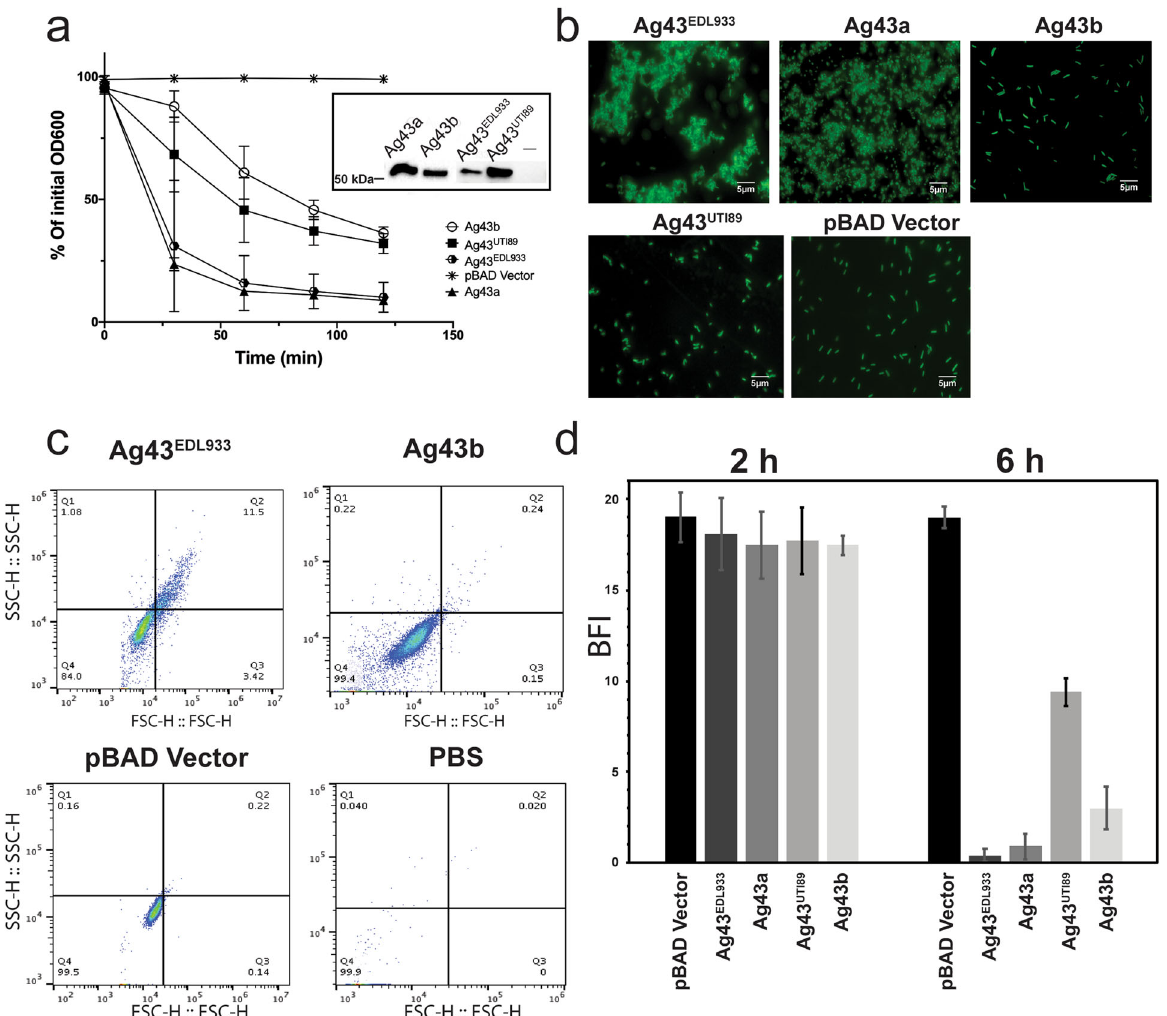
Fig. 1 Aggregation kinetics of E. coli expressing the different Ag43 variants. a MS528 expressing Ag43a, Ag43b, Ag43 UTI89 or Ag43 EDL933 were left to sediment for 2 h with OD 600 measurements taken at 30 min intervals. Experiments were performed in triplicate using MS528 harbouring pBAD/Myc-HisA as a negative control. Ag43 protein production at the bacterial cell surface was examined using western blot analysis (Ag43a and Ag43b production was detected using rabbit polyclonal serum raised against puri fi ed α 43a , and Ag43 UTI89 and Ag43 EDL933 production was detected with rabbit polyclonal serum raised against α 43_UTI89 / α 43_EDL933 ). b Representative images of GFP-positive OS56 cells harbouring the same Ag43 plasmids acquired using a Zeiss Axioplan 2 fl uorescence microscope, at an early 30 min timepoint. Scale bar is 5 µm. c Forward vs. side scatter plot for fl ow cytometry performed on OS56 harbouring plasmids encoding Ag43 EDL933 or Ag43b, control MS528 cells harbouring pBAD/Myc-HisA or PBS. These cells were induced with arabinose and analysed at exponential growth phase. d Results from the bio fi lm ring microtitre plate assay using MS528 expressing Ag43a, Ag43b, Ag43 UTI89 or Ag43 EDL933 . Measurements are shown after 2 and 6 h of sessile growth. Results are expressed as bio fi lm formation index (BFI), where lower values indicate increased bio fi lm formation; a BFI ≤ 2 is indicative of strong bio fi lm production. Error bars correspond to the standard deviation calculated from three independent